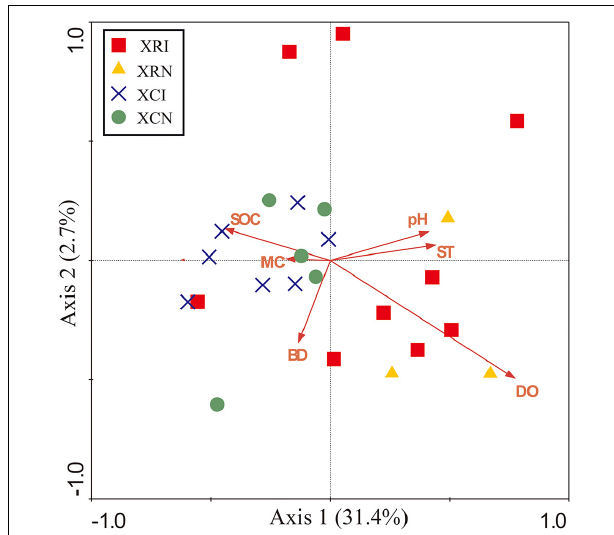
FIGURE 5 | Redundancy analysis (RDA) diagram illustrating the relationships between the soil bacterial community in invaded sites and non-invaded sites in the two types of wetlands and soil physicochemical properties. Axis 1 explained the maximum variation at 31.4%, and Axis 2 explained 2.7%. Points represent the soil samples. XRI, Xinxue River invaded sites; XRN, Xinxue River non-invaded sites; XCI, Xinxue River Constructed Wetland invaded sites; XCN, Xinxue River Constructed Wetland non-invaded sites. Red arrows represent the soil physicochemical properties: pH, SOC, soil organic carbon content; SOCD, soil organic carbon density; MC, moisture content; BD, bulk density; DO, dissolved oxygen; ST, soil temperature.